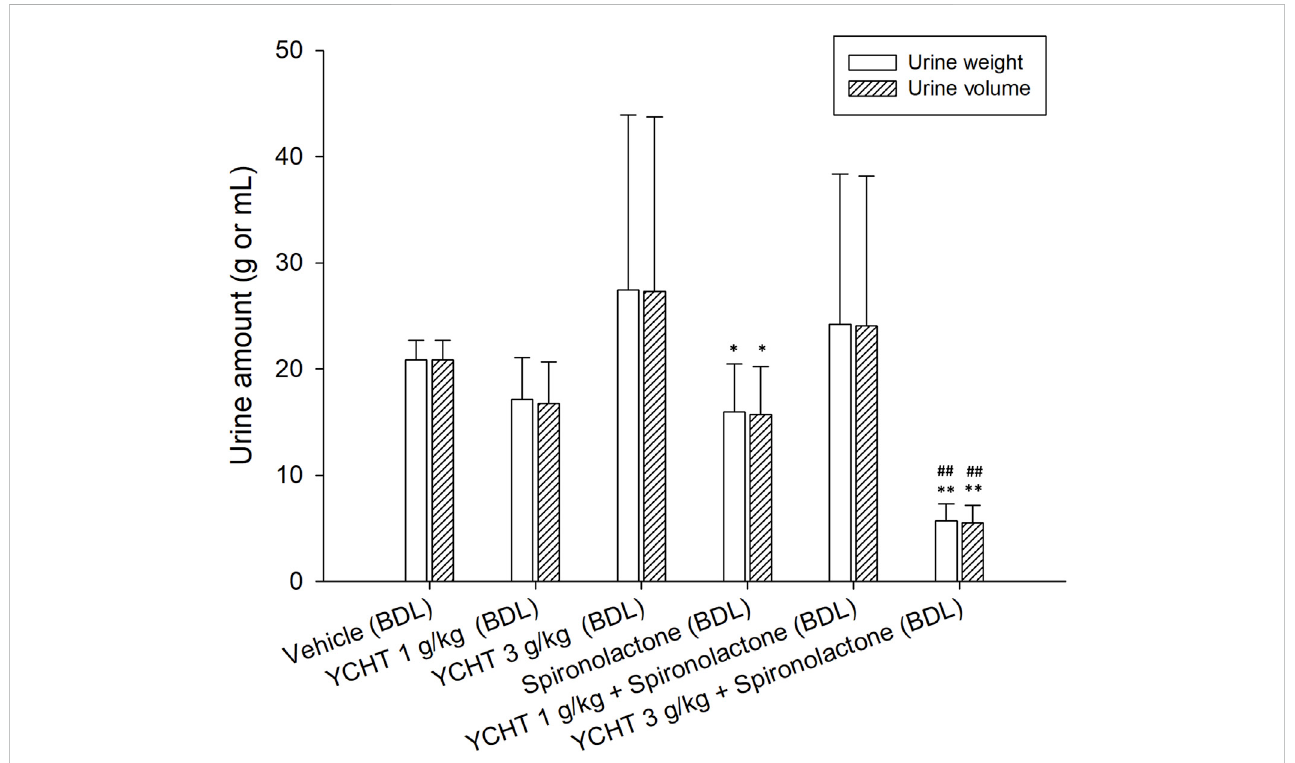
FIGURE 4 Totalurineweightandvolumeafteroraladministrationofspironolactoneineachgroup.Dataweresigni fi cantlydifferentbyt-test.* p < .05and** p < .01; signi fi cance compared to the vehicle group; ## p -value < .01; signi fi cance compared to the spironolactone group; YCHT,